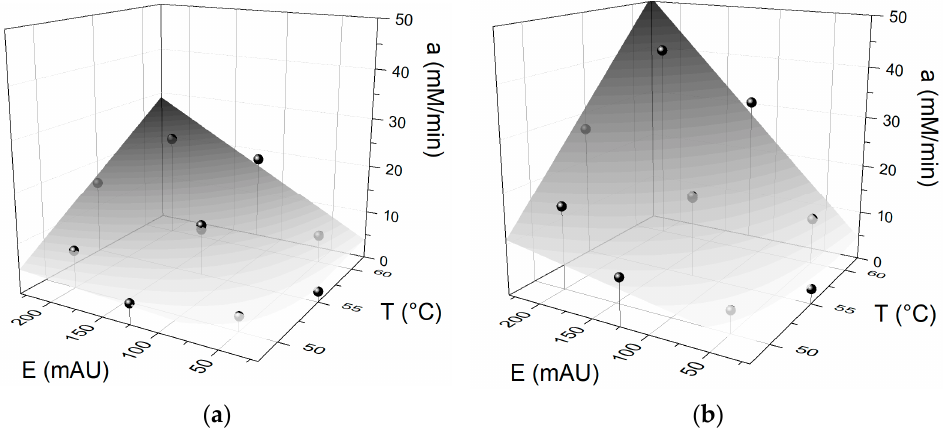
Figure 2. Response surfaces for kinetic constant a against the operating conditions T and E for the hydrolysis of milk proteins with ( a ) Alcalase and ( b ) Protamex. Table 4. Regression and variance analysis for RSM models for kinetic constants a and b for the en- zymatic hydrolysis of milk proteins with Neutrase.